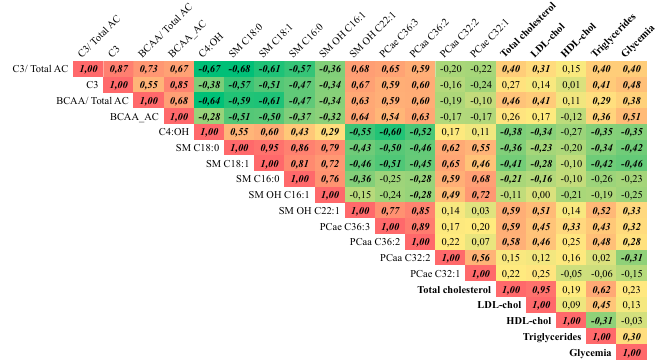
Figure 5. Correlation matrix. Spearman’s correlation of the variables with high VIP values in the PLS-DA model with clinical chemistry parameters. n = 26. Only data from before and three months after the RYGB surgery were used. r values in bold/ italic indicate that the correlation has a p < 0.05.C3 = propionyl carnitine; C3/ Total AC = ratio between C3 and the sum of all AC; BCAA_AC = AC derived from BCAA; BCAA_AC/total AC = ratio between the sum of AC derived from BCAA and the sum of all AC; C4:OH = 3-Hydroxybutyrylcarnitine; SM 18:0 = octadecanoyl sphingomyelin; SM 18:1 = oleoyl sphingomyelin; SM 16:0 = palmitoyl sphingomyelin;, SM OH 16:1 = Hydroxy-palmitoleyl sphingomyelin; SM OH 22:1 = Hydroxy-docosaenoicoyl sphingomyelin; PCae 36:3 = ether-linked phosphatidylcholine C36:3; PCaa 36:2 = phosphatidylcholine C36:2; PCaa 32:2 = phosphatidylcholine C32:2; PCae 32:1 = ether-linked phosphatidylcholine